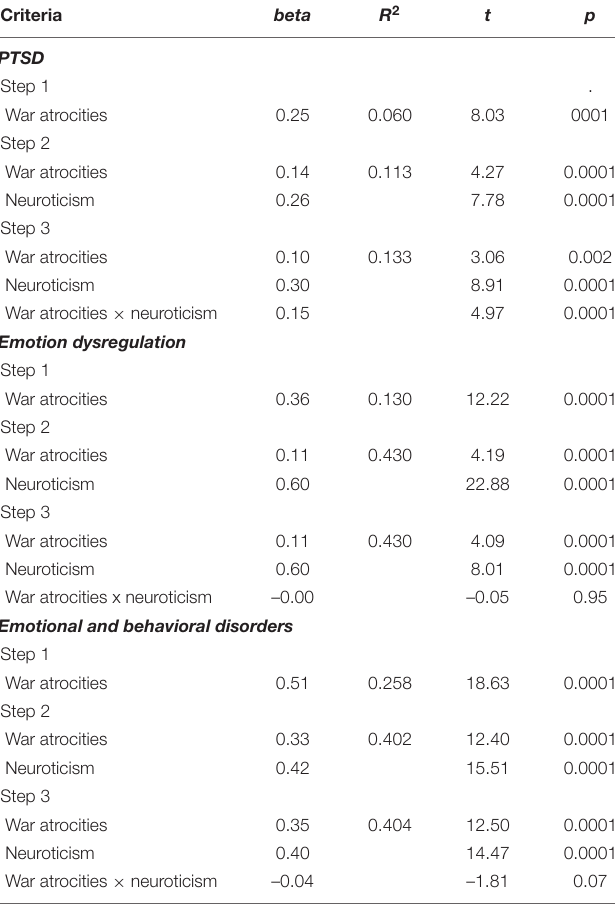
TABLE 3 | Hierarchical regression models predicting the occurrence of PTSD, emotion dysregulation, and emotional, and behavioral disorders in refugee